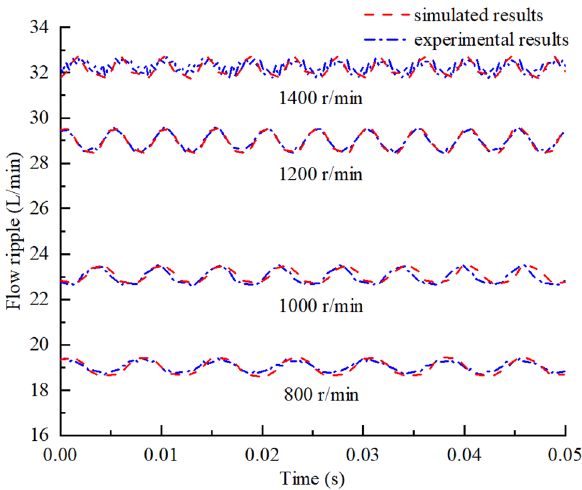
Figure 36. Comparison of flow ripple results under different pump speeds ( P 0 = 5